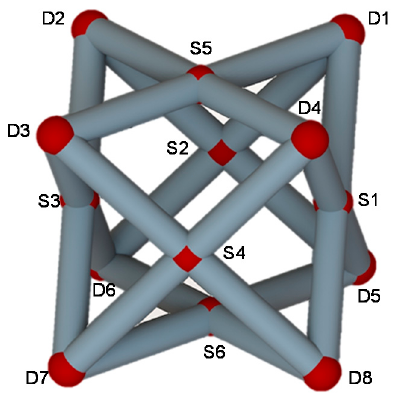
Figure 4. Generated optimal unit cell model based on the topology optimization method. Table 1. Ground structure optimization results of the cross-sectional areas of each strut element.